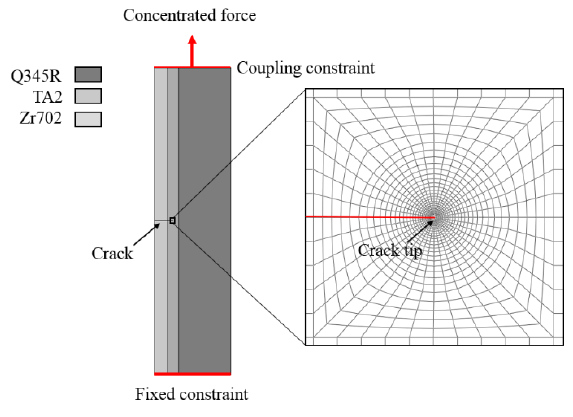
Figure 2. Finite element model of Type-A specimen.